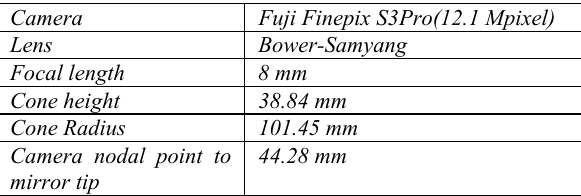
Table 1: Camera and cone-shaped mirror technical features.